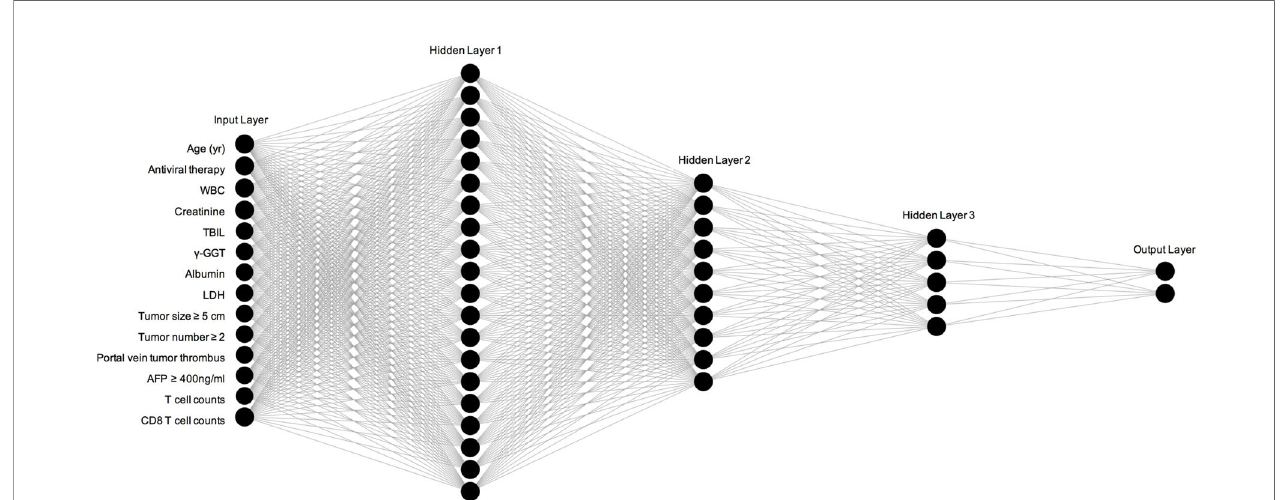
FIGURE 2 | Construction and speci fi c structure of ANN model. WBC, white blood cells; TBIL, total bilirubin; LDH, lactate dehydrogenase; AFP, Alpha fetoprotein.